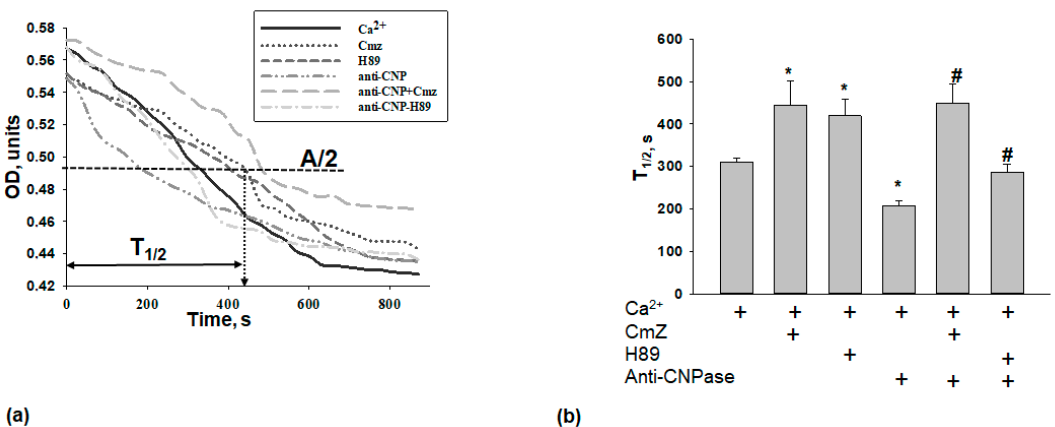
Figure 3. Effect of CmZ, H89, and anti-CNPase antibody, and their combined effect on RBM swelling. ( a ) Curves of RBM swelling in the presence of CmZ (30 µ M), H89 (5 µ M), and anti-CNPase antibody (0.18 µ g/mL); ( b ) Average results of the half-time (T 1/2 ) swelling. The values shown are the means ± SD from three independent experiments; * p ≤ 0.05 vs. T 1/2 without any additions, # p ≤ 0.05 vs. T 1/2 in the presence of anti-CNPase antibody. OD—optical density, A/2—half amplitude of mitochondrial swelling.